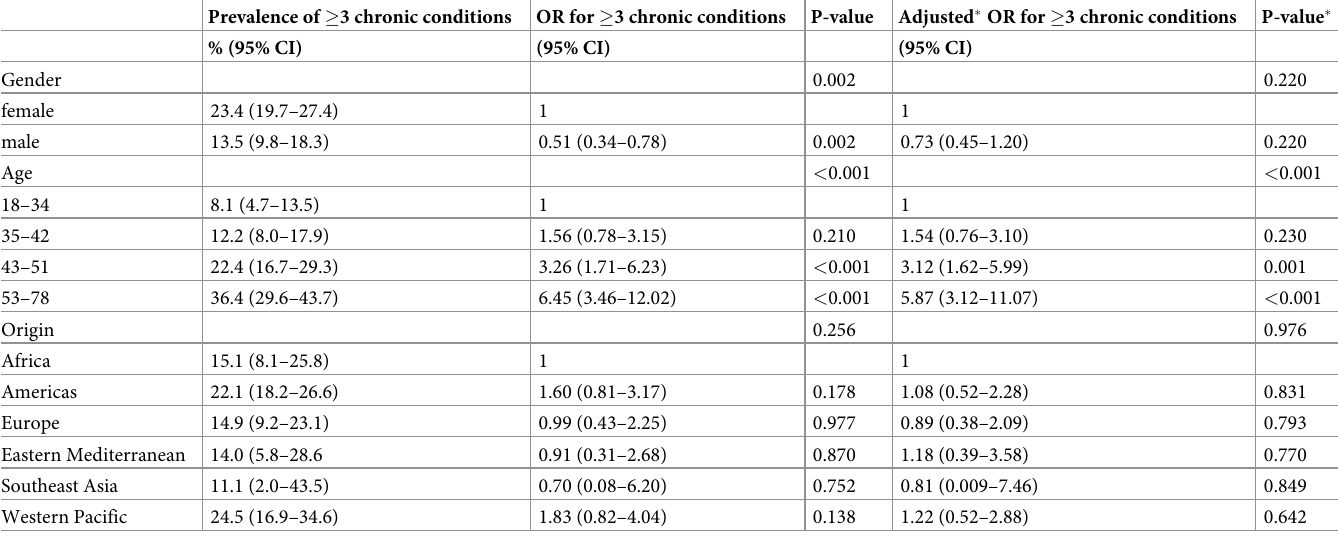
Table 3. Factors associated with multimorbidity in undocumented migrants. Prevalence of (cid:21) 3 chronic conditions OR for (cid:21) 3 chronic conditions P-value Adjusted (cid:3) OR for (cid:21) 3 chronic conditions P-value